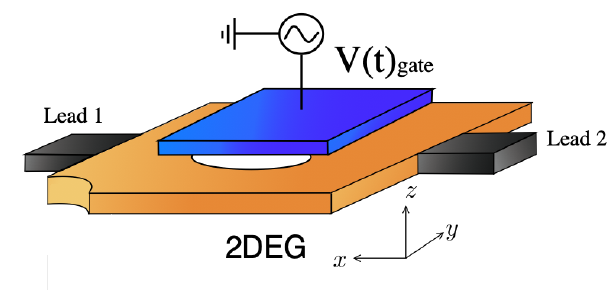
Figure 2: Sketch of the spin current source. A time-dependent top gate voltage is ap- plied to a (chaotic) ballistic cavity connected to two leads, which controls the Rashba coupling and thus creates a spin electric force.